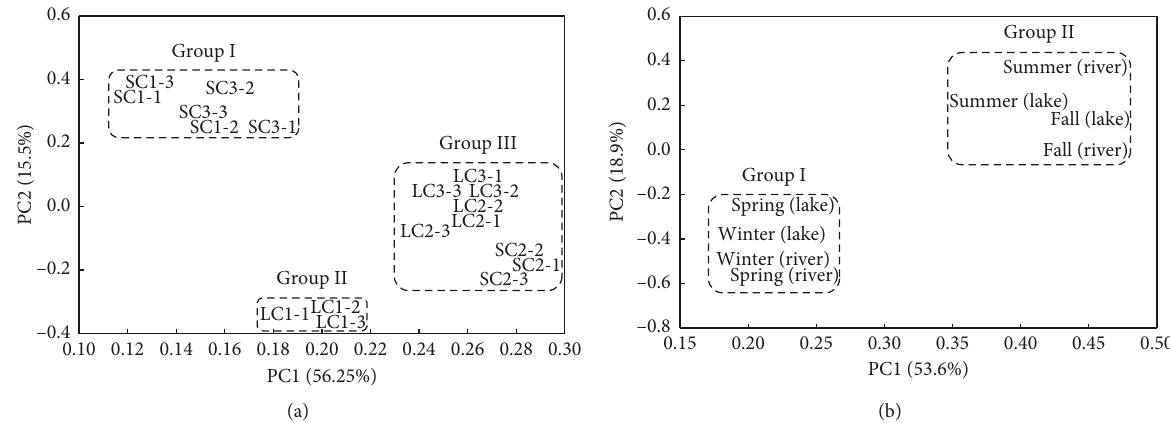
Figure 6: Ordination diagrams of CLPPs from principal component analyses of carbon utilization profiles of lake and river samples from different sites (a) and different seasons (b).